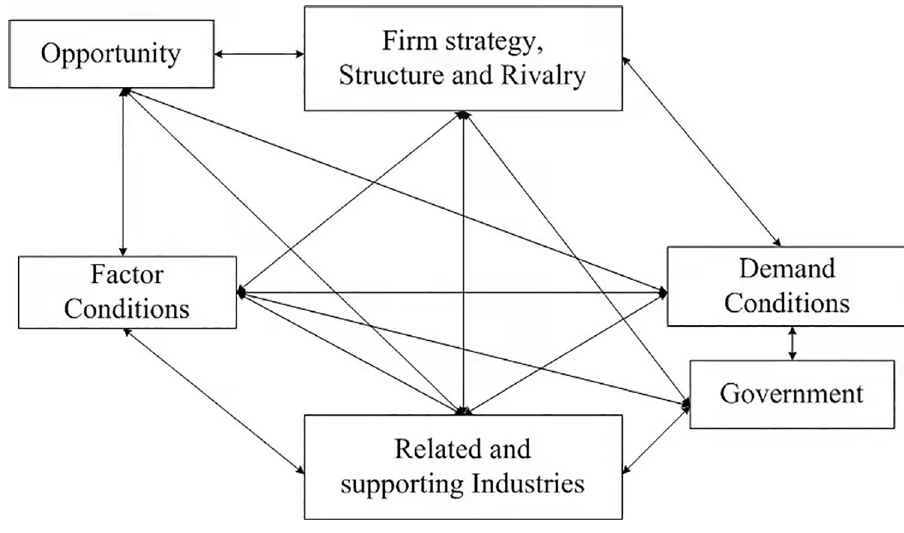
Fig 4. Michael Porter’s “diamond